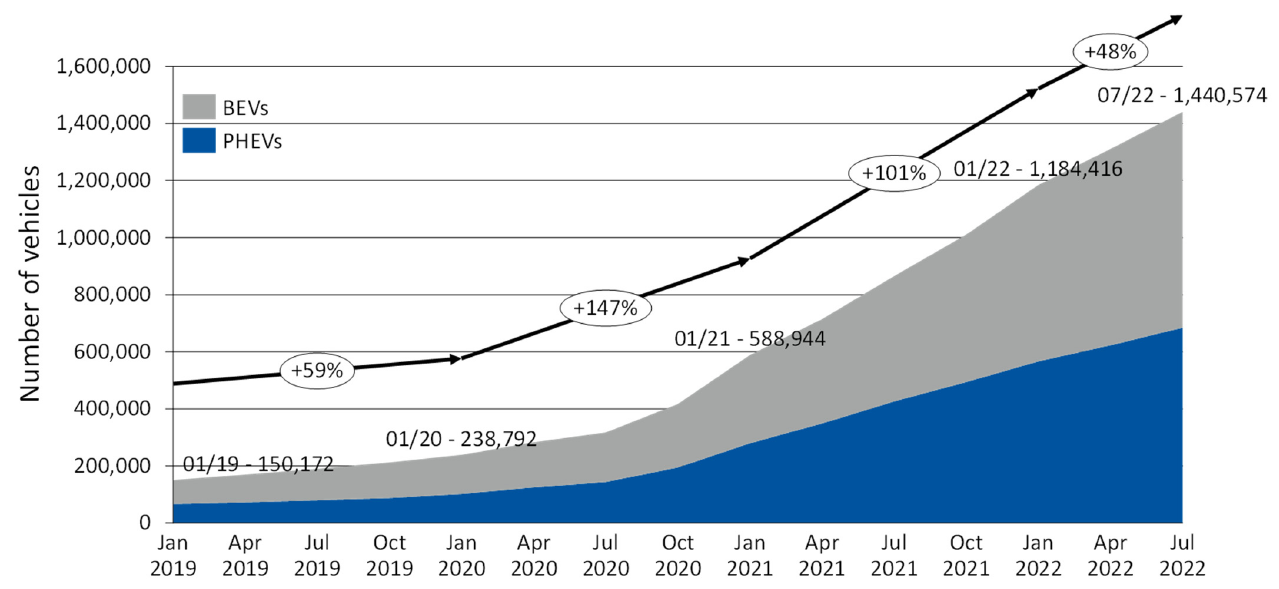
Figure 1. Numbers of BEVs and PHEVs in Germany in monthly resolution. Arrows show year-on- year growth of the sum of both categories. Percentage in 2022 assumes an equal growth for the rest of the year. Data labels show number of registered vehicles at the beginning of the year and indicated dates on the x -axis are on the first day of the month. * For 2022, the percentage shown assumes a constant growth rate over the year. Table 2. Numbers of BEVs and PHEVs by state. The sum of all vehicles differs from the value shown for the same time in Figure 1 due to 1676 vehicles that do not appear in the state registry but do appear in the countrywide registry. Numbers of inhabitants and cars are given as reference